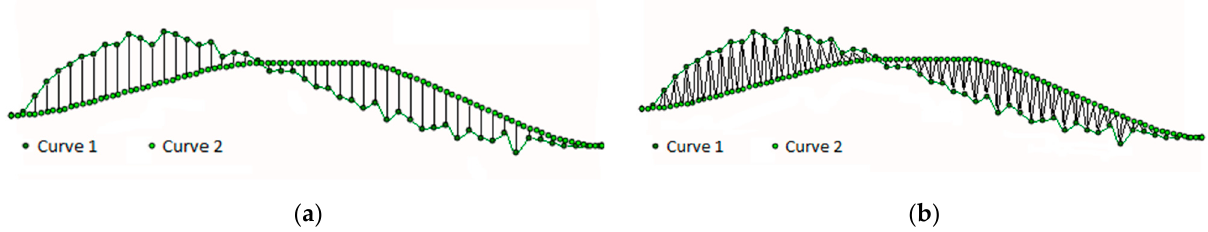
Figure 5. ( a ) Curves comparison approach with the Euclidean norm; ( b ) curves comparison approach with the DTW algorithm.